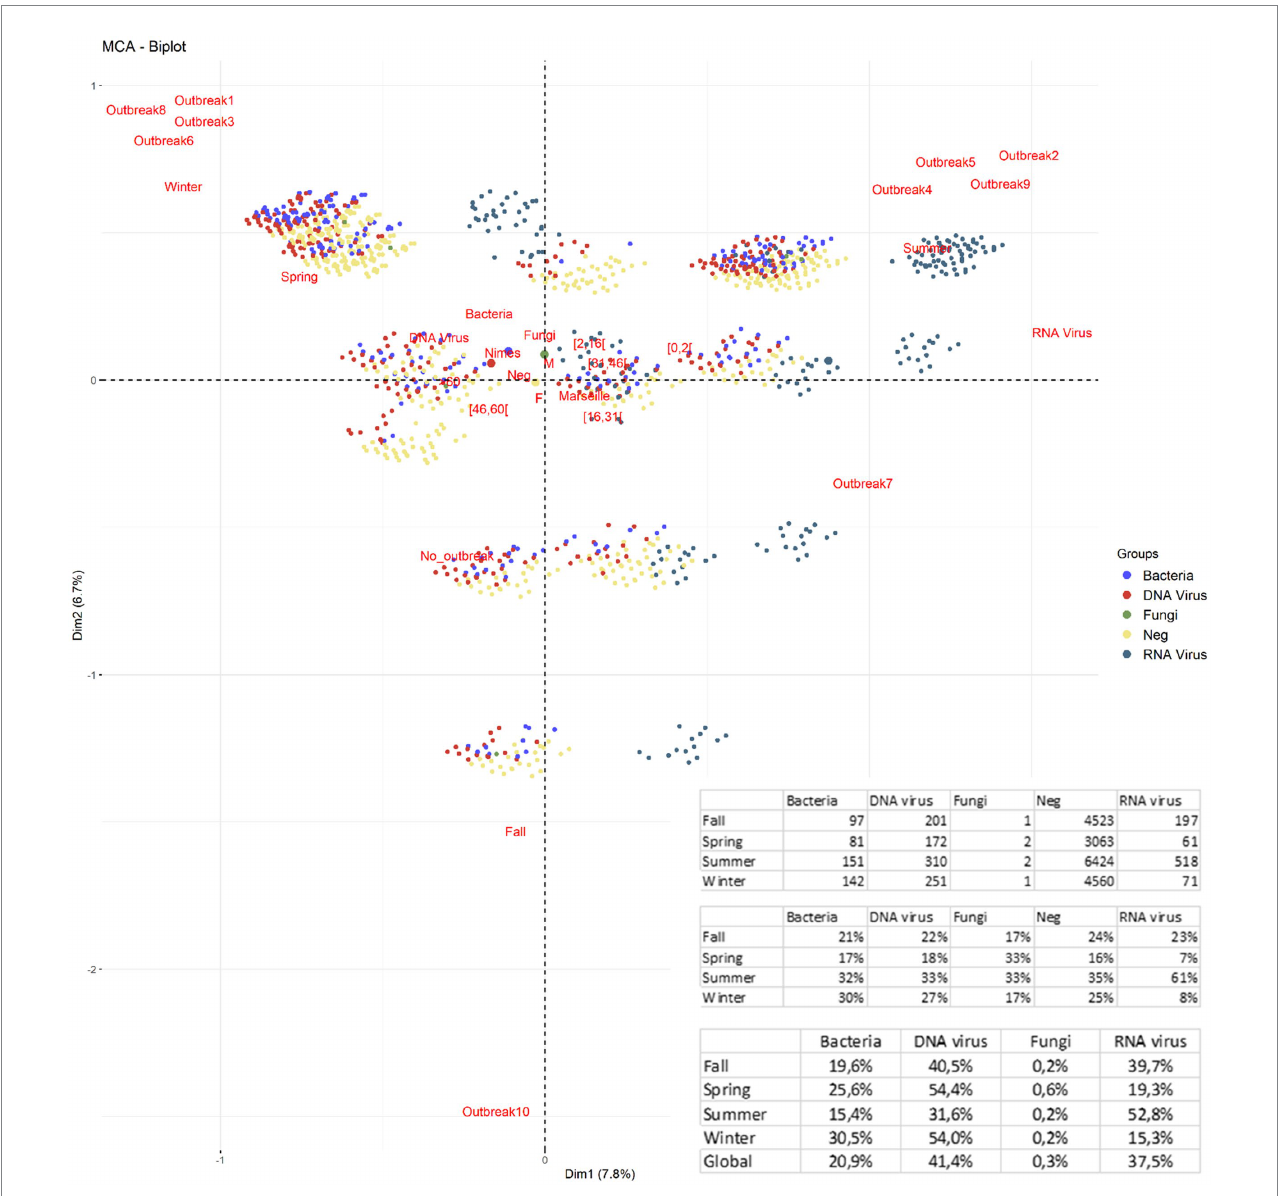
FIGURE 5 Multiple correspondence analysis (MCA) of the variables of seasons, outbreak number, identified pathogens gathered by microorganisms’ groups (RNA virus, DNA virus, Bacteria, and Fungi), gender, and age. In summer, five outbreaks caused by RNA viruses infecting young patients (61%), represented 52.8% ( p < 10 − 4 ) of summer outbreaks. DNA viruses occurred in all seasons with a more equal distribution but accounted for ~54% ( p < 10 − 4 ) of both spring and winter outbreaks. Although bacteria were less season-specific, they were nevertheless more frequent in winter (30% of bacteria were detected in winter) and accounted for 30.5% of winter epidemics ( p < 10 − 4 ). According to the ACM, RNA viruses are the furthest from the center of the benchmark and are associated with summer. Bacteria and DNA viruses are closer to the center, so less season-specific, but still closer to winter and spring. Undocumented cases mainly clustered with bacteria and DNA viruses in winter and with all etiologies in summer, notably with RNA viruses, especially for young patients. *Fisher’s Exact Test for Count Data with simulated p value (based on 2,000 replicates), ( p value =